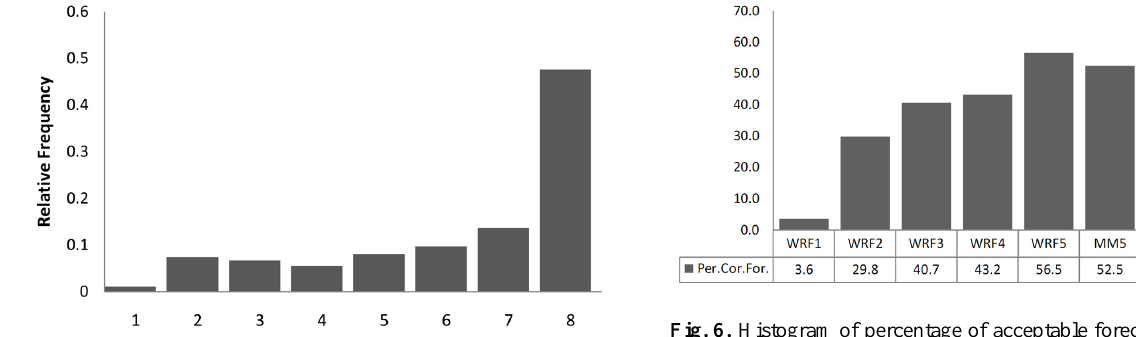
Fig. 4. Rank histogram of the raw ensemble for 48-h surface tem- perature forecasts.